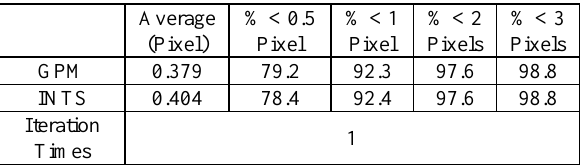
Table 1. Accuracy Evaluation of GPM on Adirondack Stereo